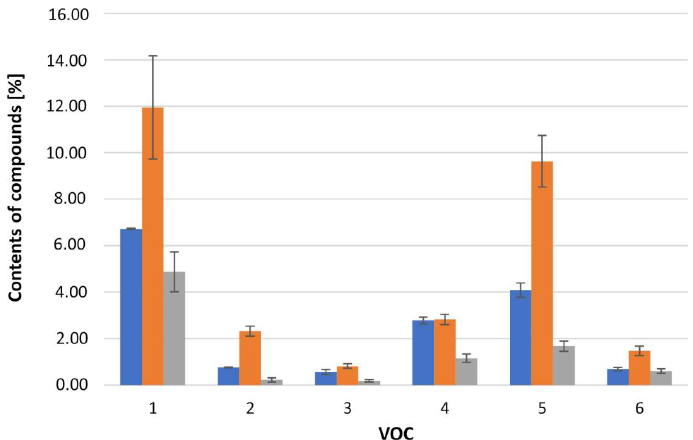
Figure 2. Comparison of the percentage of VOC in the three seasons. Compounds: 1 — anastreptene ( 25 ), 2 —δ -elemene ( 22 ), 3 — selina-5,11-diene ( 41 ), 4 — germacrene D ( 47 ), 5 — bicyclogermacrene ( 49 ), 6 — cuparene ( 51 ). Seasons: spring, summer, autumn.